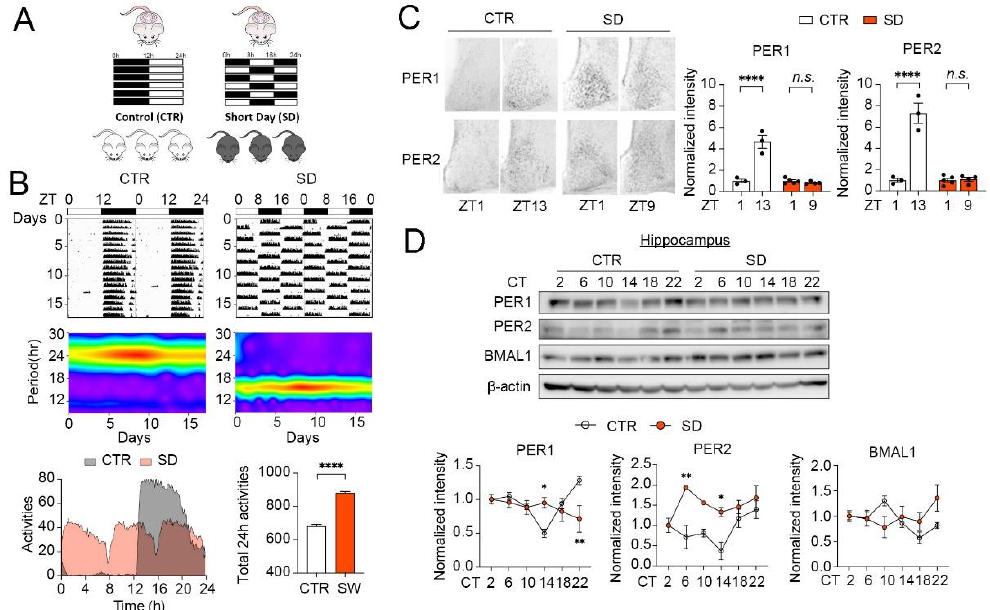
Figure 1. Daily rhythms of animal locomotor activities and clock gene expression are disrupted in SD mice. ( A ) A diagram indicating the strategy to generate the SD mice. ( B ) Top: Representative actograms of mouse wheel-running activities in control (CTR) and Short Day (SD) mice. Middle: Morlet wavelet transform analysis below indicates that CTR mice entrained to the 12 h/12 h light/dark cycle and exhibited a circadian period of 24 h. In contrast, SD mice entrained to the 8 h/8 h light/dark cycle and exhibited a circadian period of 8 h. Bottom: Average activities of CTR (n = 4) and SD (n = 3) mice across 24 h. Note that the SD mice exhibited a higher level of total activities in 24 h as compared with the CTR mice. ( C ) Representative microscopic images of immunostaining for PER1 and PER2 in the SCN. ZT1: one hour after light-on for CTR and SD mice; ZT13 and ZT9: 1 h after light-off for CTR and SD mice. Quantitative analysis of staining intensity is shown to the right. The levels at ZT13 and ZT9 were normalized according to the levels at ZT1 in the CTR and the SD mice, respectively. Note that PER1 and Per2 levels were not different between ZT1 and ZT9 in SD mice. Data are displayed as individual values and mean ± SEM. n = 3 in CTR and n = 4–5 in SD. **** p < 0.0001; n.s., not significant vs. ZT1. ( D ) Western blotting images indicate that PER1, PER2, and BMAL1 exhibited circadian oscillations in the hippocampi of the CTR, but not the SD, mice. Quantitation of protein levels is shown below. For this experiment mice were kept in constant darkness for 48 h and hippocampal samples were harvested every 4 h in the next 24 h. Data are displayed as mean ± SEM. n = 3 in CTR and SD. ** p < 0.01; * p < 0.05 vs. CTR.